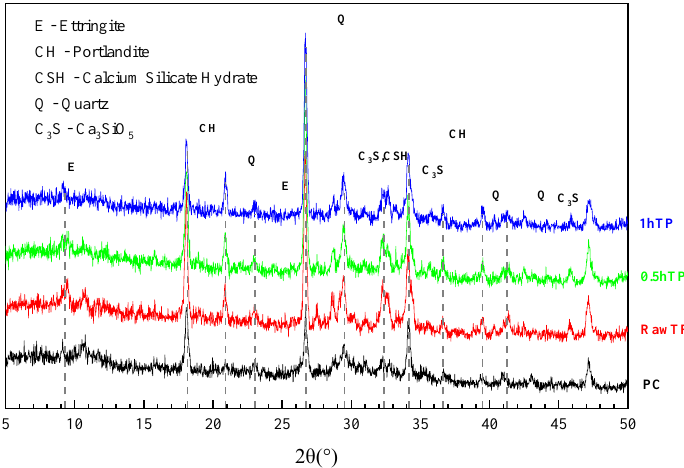
Figure 13. XRD results of cementitious pastes.